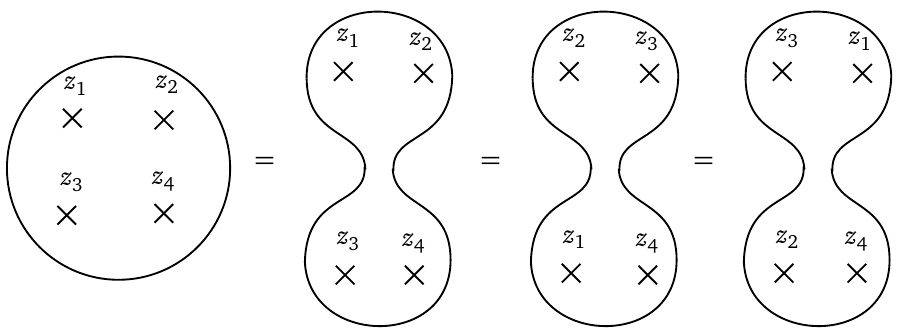
Figure 3: Duality frames of the theory constructed by gluing two D and one